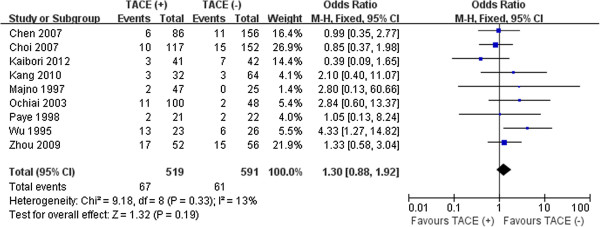
Results of the meta-analysis on extrahepatic recurrence.